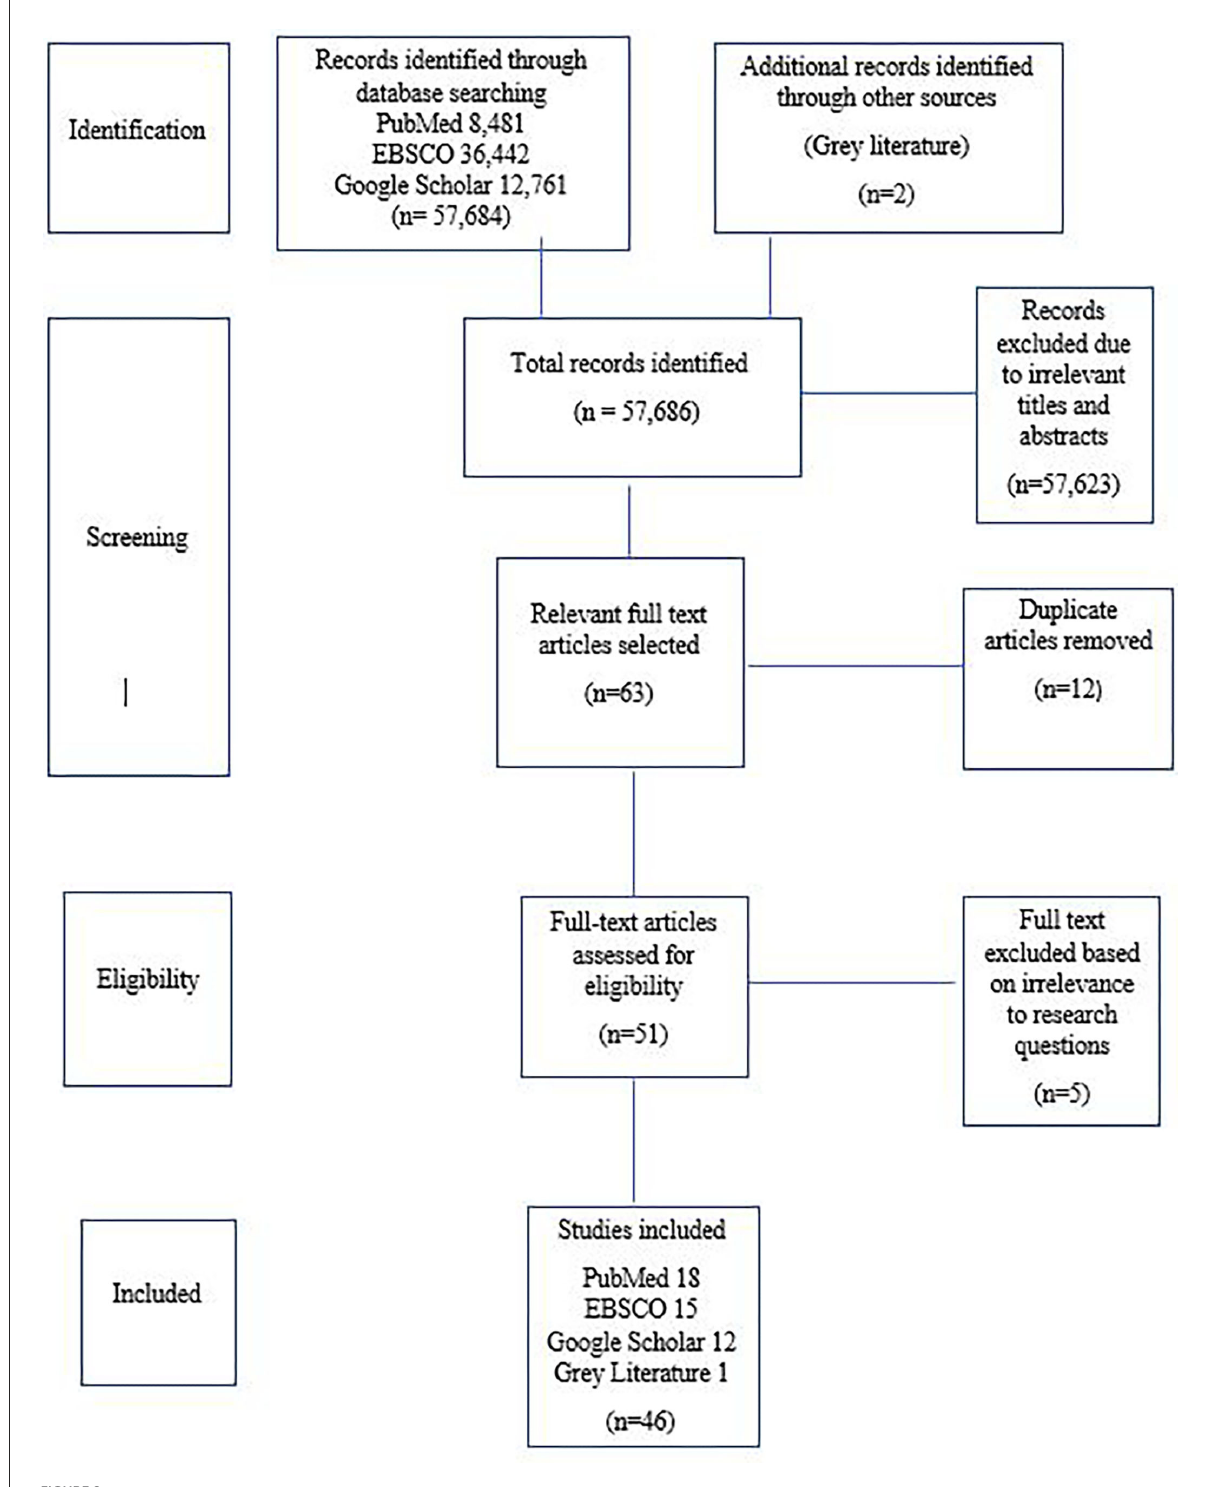
FIGURE2 Prisma flow